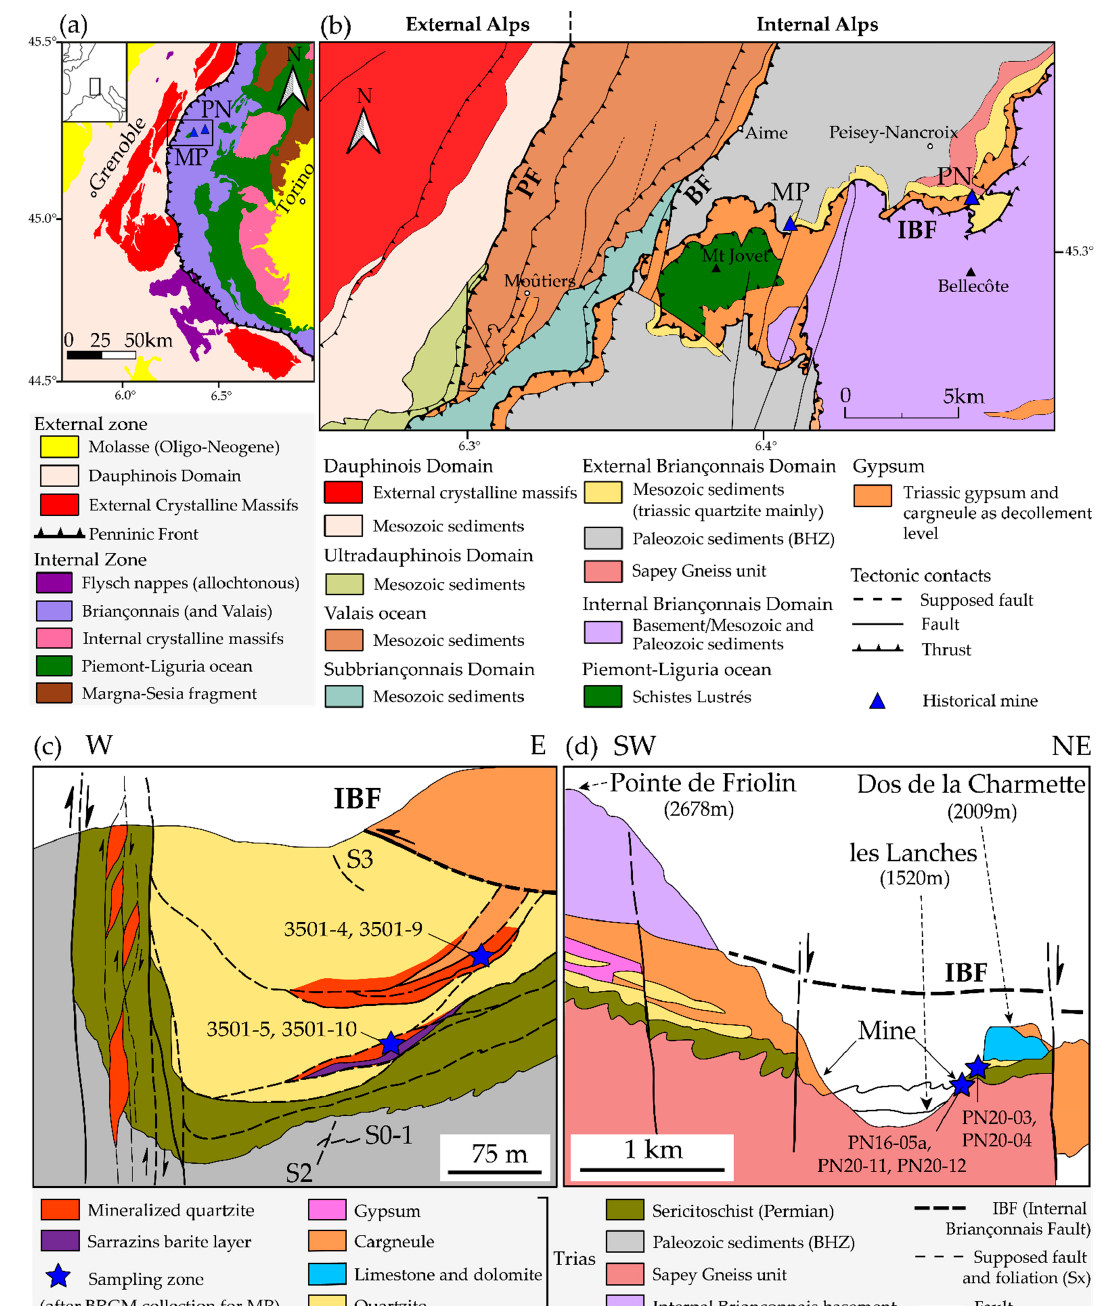
Figure 1. Geological map of ( a ) the Western Alps (after “Armada” France database) with square representing map b location; ( b ) the Briançonnais zone between the Lauzière and Vanoise massifs (modified after the Moûtiers geological map (1:50,000) by J. Debelmas). MP: Macôt-la Plagne; PN: Peisey-Nancroix; PF: Penninic Front; BF: Briançonnais Front; IBF: Internal Briançonnais Front. Additionally, sections modified after Guillot [22] of the ( c ) Macôt-la Plagne mine; and ( d ) Peisey-Nancroix valley. Sampling zones are given with the sample references. BHZ: Briançonnais Houiller